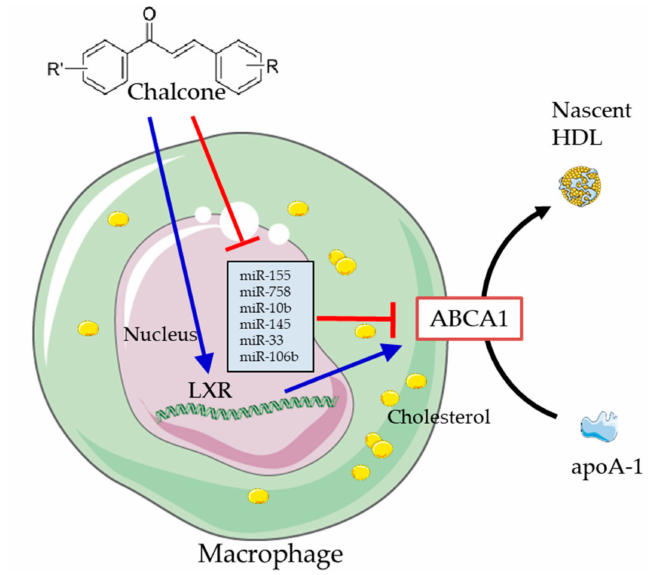
Figure 5. Potential mechanisms of the chalcone derivative ( 1m ) in regulation of ABCA1 expression in